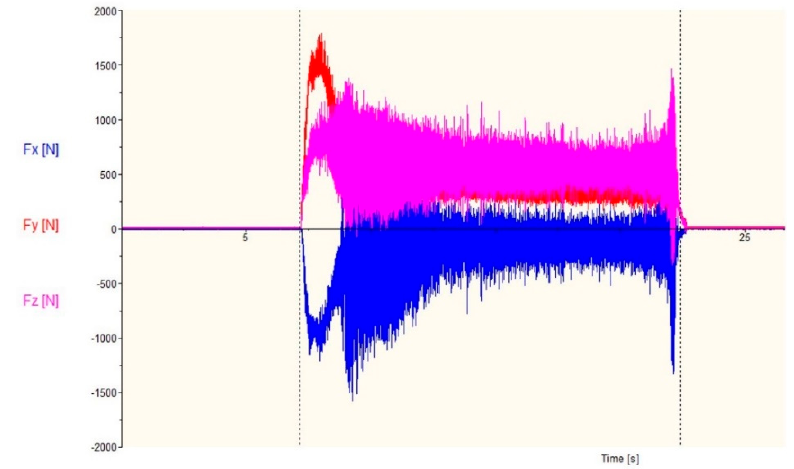
Figure 12. Cutting forces during turning with parameters: ap = 2.0 mm, f = 0.075 mm / rev. A further cutting process was performed with a cutting depth of 2.0 mm and a feed rate of 0.10 mm / rev, and despite the damage to the cutting insert, the analysed forces did not reach such significant values (Figure